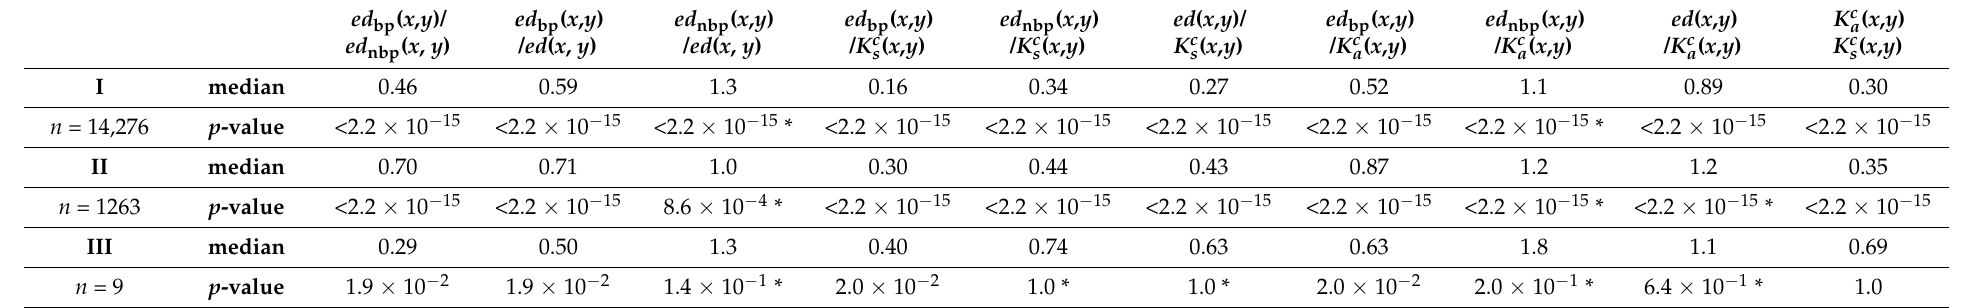
Table 3. Medians and corrected p -values of ten distance ratios for three genotypes. The size of the samples of each genotype is indicated by n . The corrected p -values were calculated by the left-sided test (the alternative hypothesis is that the median is less than 1.0) or the right-sided test (the alternative hypothesis is that the median is greater than 1.0.). The asterisk indicates the p -value calculated by the right-sided test. The floating point number representation is used to express the p -values.